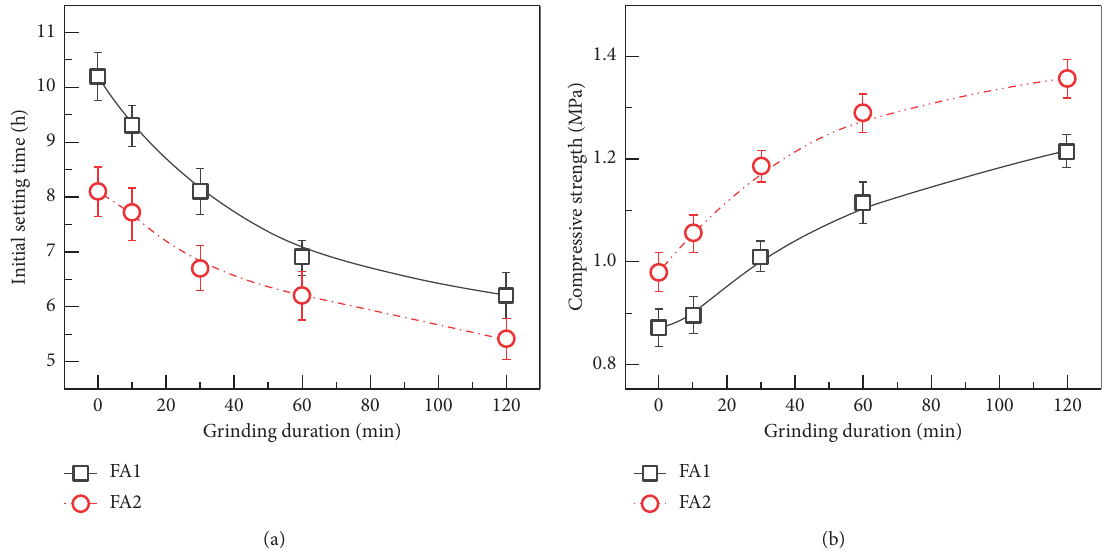
Figure 11: Initial setting time (a) and 28 d compressive strength